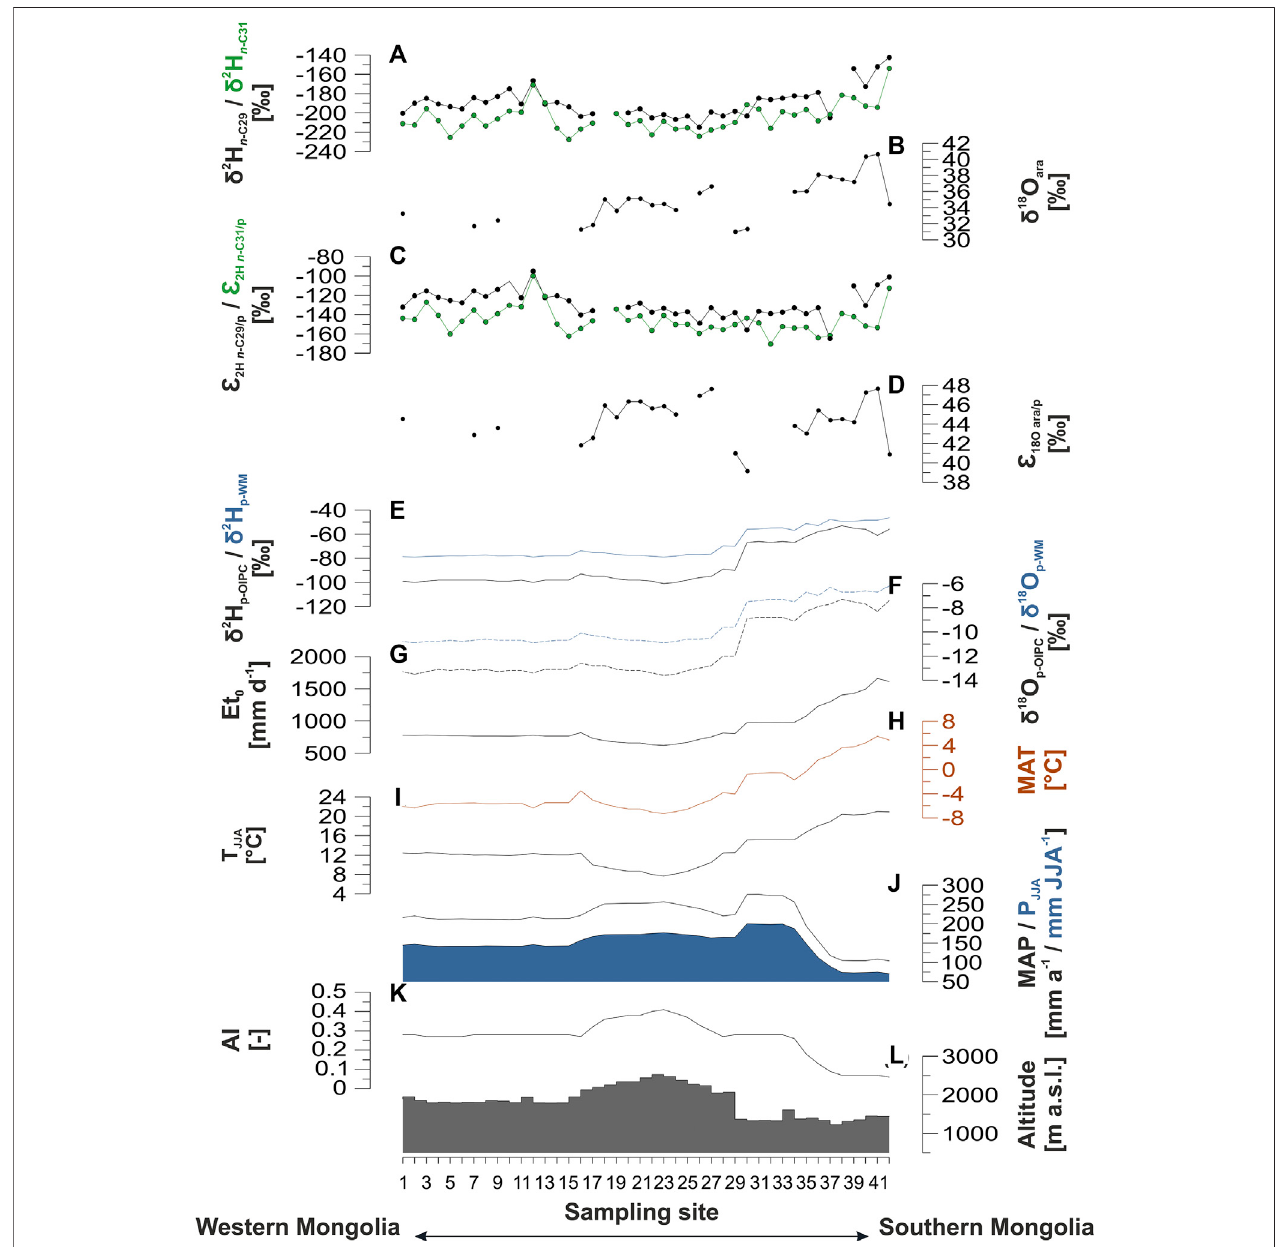
FIGURE 2 | δ 2 H and δ 18 O signatures of leaf wax-derived n -alkanes and the hemicellulose sugar arabinose as well as their apparent isotope fractionation ( Ɛ app ), comparedtoenvironmentalandclimaticparametersalongthetransect (A) Compound-speci fi c δ 2 Hoftheleafwax-derived n -alkane n -C 29 (black)and n -C 31 (green)(this study) (B) compound-speci fi c δ 18 O ara (this study) (C) Ɛ 2H n -C29/p (black) and Ɛ 2H n -C31/p (green) (this study) (D) Ɛ 18O ara/p (this study) (E, F) OIPC isotopic composition of precipitation(blackline)andamount-weightedisotopicsignatureofprecipitation(blueline): δ 2